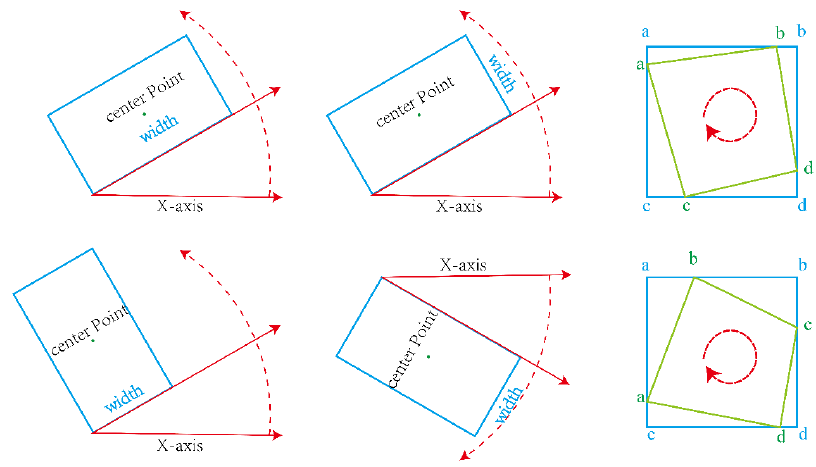
Figure 6. Three ways to represent the rotating box: the first column is the Open CV notation, the second column is the long-side representation and the third column is the four-point notation.